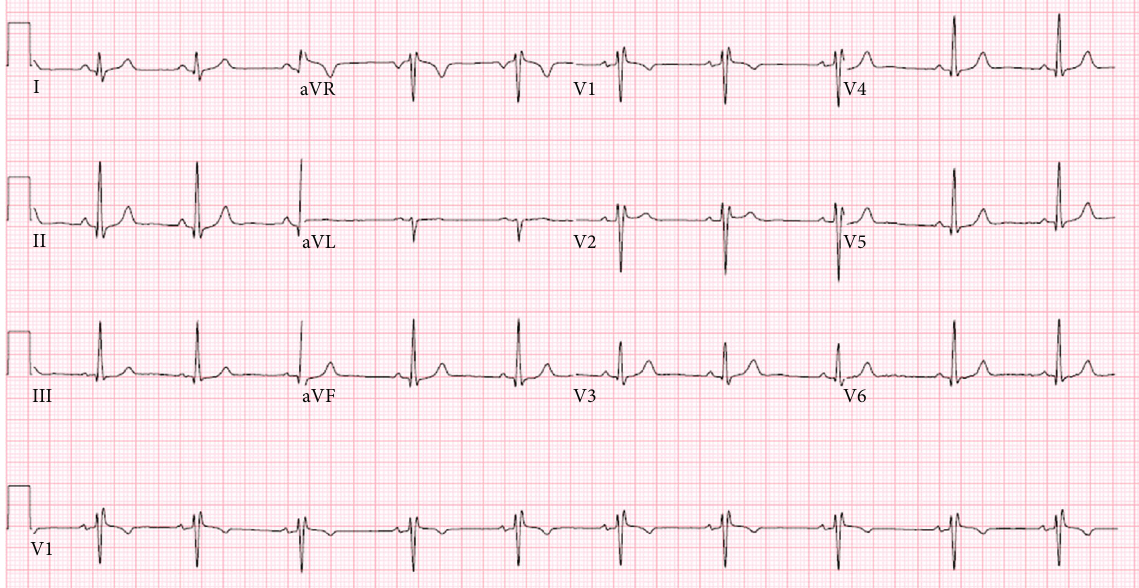
Figure 1: Normal sinus rhythm. RSR ′ or QR pattern in V1 suggests right ventricular conduction delay.